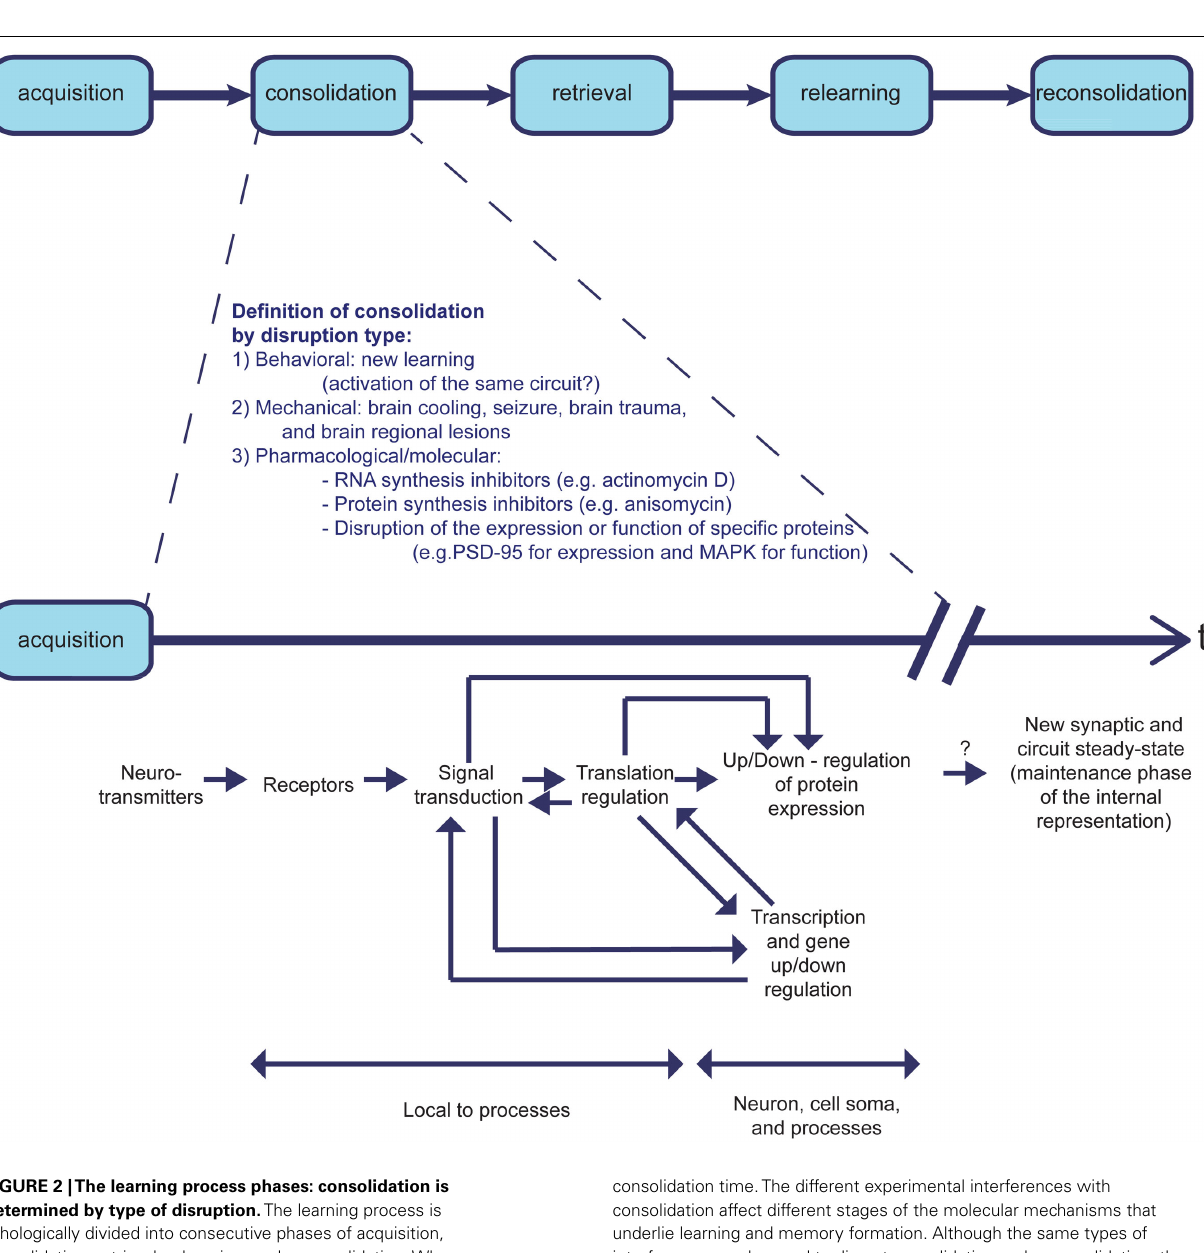
consolidation time.The different experimental interferences with consolidation affect different stages of the molecular mechanisms that underlie learning and memory formation. Although the same types of interference may be used to disrupt consolidation and reconsolidation, the time windows of sensitivity to disruption differ between the two phases of learning. It is therefore unclear whether the molecular processes that occur during consolidation are identical to the ones that occur during